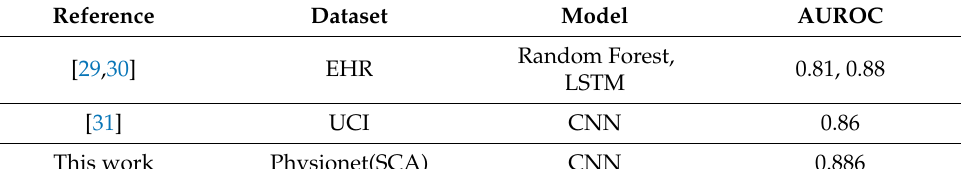
Table 6. Comparison with other ML works.